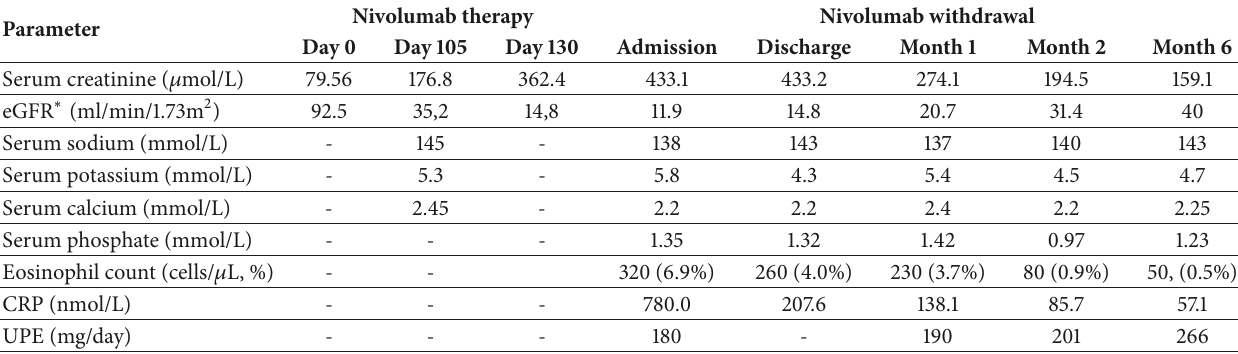
Table 1: Patient laboratory value after initiation of immunotherapy with